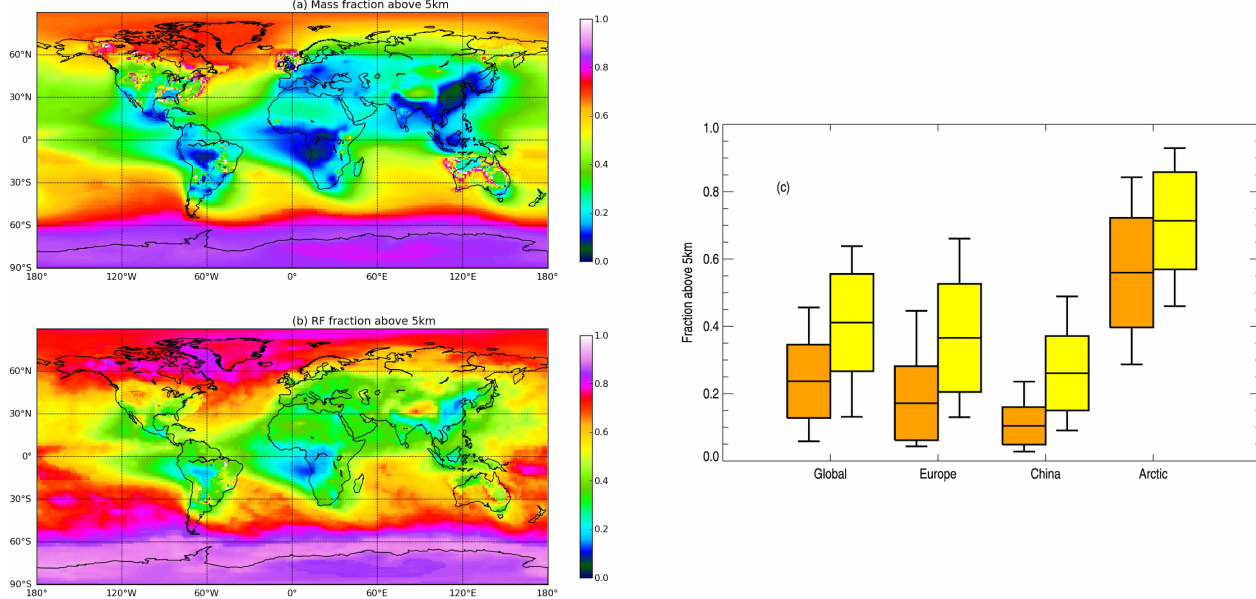
Fig. 3. Black carbon mass and induced forcing at high altitudes. (a) Fraction of modeled BC mass above 5km. (b) Fraction of modeled BC RF originating above 500hPa (5km). (c) Mean fraction of mass (orange) and RF (yellow) globally and for three selected regions. Boxes indicate one standard deviation on the model spread, whiskers show maximum and minimum